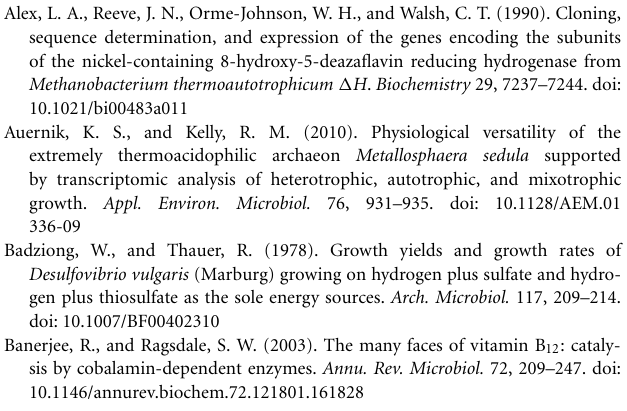
Figure S1 | Distribution of array abundance and correlation with and central metabolic processes. (A) Distribution of intensity of quantile-normalized data; ( A-I ) distribution of values corresponding to minimum expression per gene and ( A-II ) maximum expression per gene. (B) Gene set enrichment analysis (GSEA) (Subramanian et al., 2005) on the distribution of selected genes on a list of genes sorted by minimum intensity values (i, corresponding to pie chart A-I ), i.e., deviation from a random distribution, is displayed for identified peptides and genes corresponding to KEGG pathways. The maximum enrichment score (ES) corresponds to the largest deviance from random distribution, the region above the maximum enrichment score corresponds to the leading edge (LE), this region is colored corresponding to the intensity at point of ES. The numbers denote—[values below LE/above